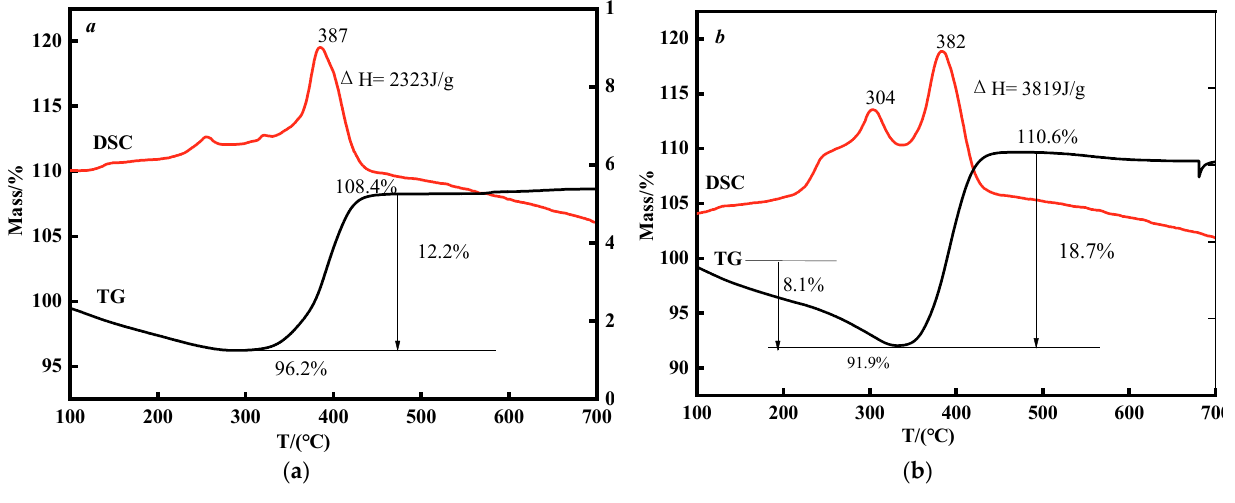
3819 J ⋅ g − 1 , which is higher than that of uncoated nNi. The TG curve of HTPB/nNi has a weight gain in the range of 350–500 °C, which is corresponding to the oxidation exother- mic process of n Ni, and the weight gain is about 18.7%. According to formula 1, about 67.32% of nNi is oxidized, which is higher than that of pure nNi (43.92%). The TG–DSC analysis results of nNi and HTPB/nNi indicate that HTPB coating on the surface of nNi can prevent the surface oxidation of nNi and the content of active nickel was increased.